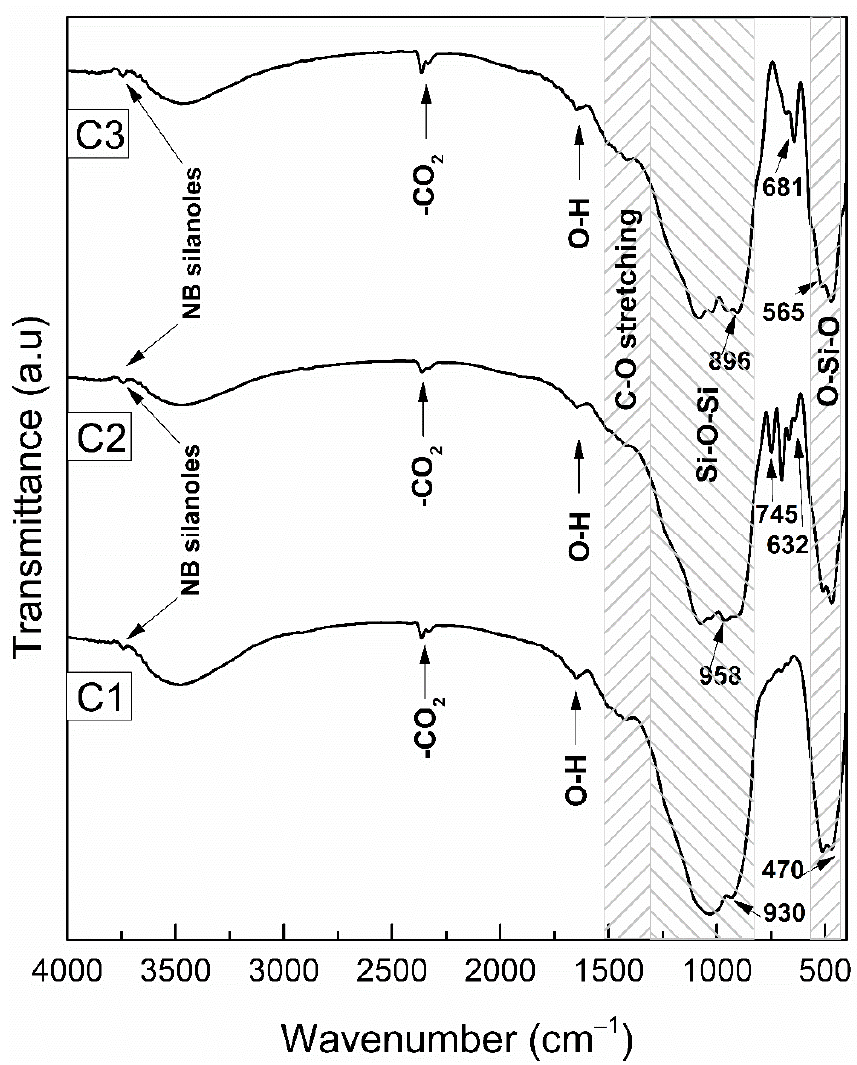
Figure 2. FTIR spectra before the immersion of the three samples in SFB.